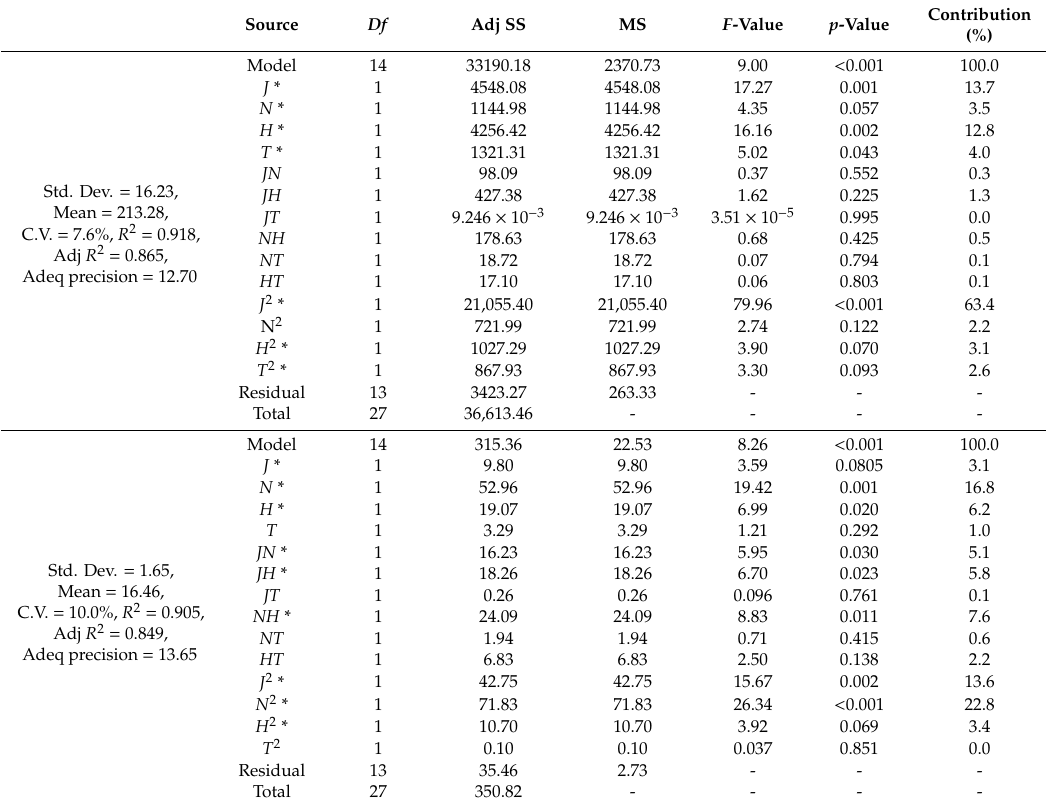
Table 6. ANOVA results of the both response models.